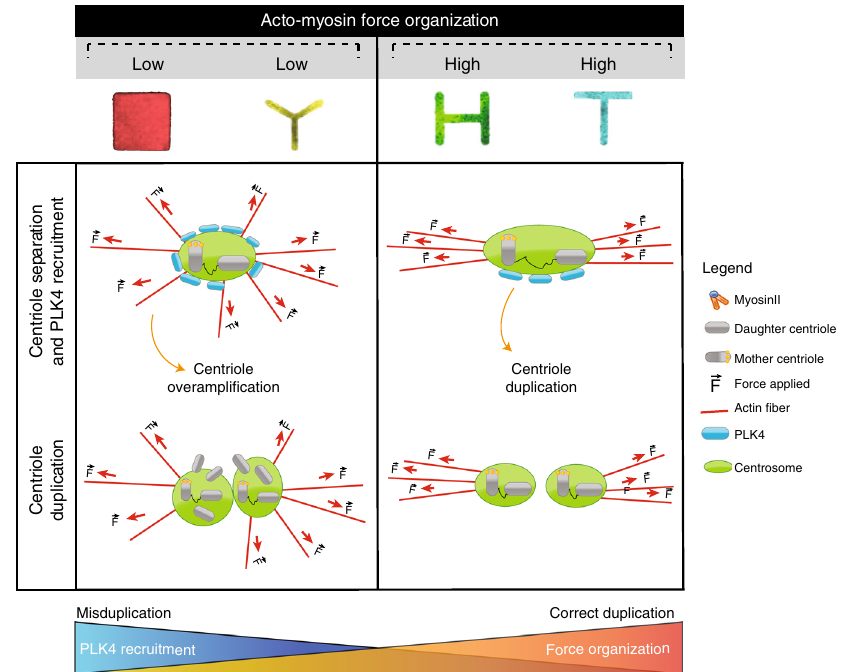
Fig. 7 Proposed model. We propose here a model in which centrioles sense acto-myosin force organization and respond via regulating centriole separation. Moreover, the degree of acto-myosin organization modulates PLK4 recruitment at the centrosome to ultimately control centriole duplication. In the proposed scenario, the PLK4 recruitment at the centrosome is inversely proportional to the degree of force organization: an excessive recruitment of PLK4 due to disorganization of acto-myosion forces triggers aberrant centriole duplication. On the contrary, well-aligned acto-myosin forces ensures the right amount of PLK4 at the centrosome and the correct centriole